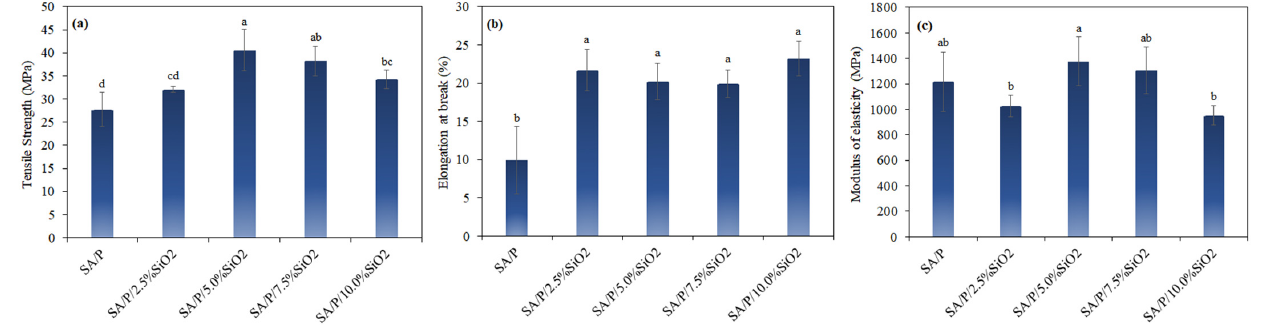
Figure 5. Mechanical properties of SA/P and SA/P/SiO 2 films—( a ) tensile strength, ( b ) elongation at break, and ( c ) modulus of elasticity. a, b, c, d The values followed by the same letter do not differ at the 95% confidence level ( p > 0.05).